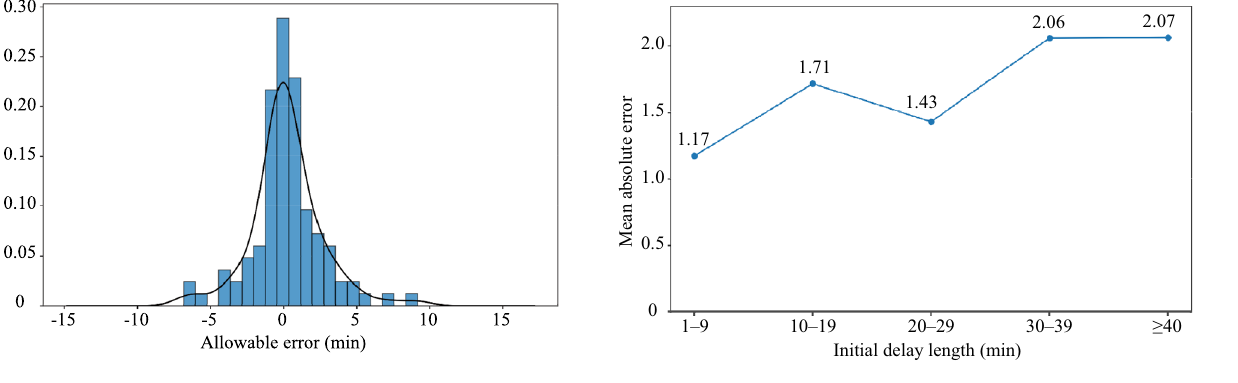
Fig. 13 Distributions of prediction residuals for test datasets Table 6 Sample sizes and percentages for different absolute values of residuals in test dataset Absolute value of residual Sample size